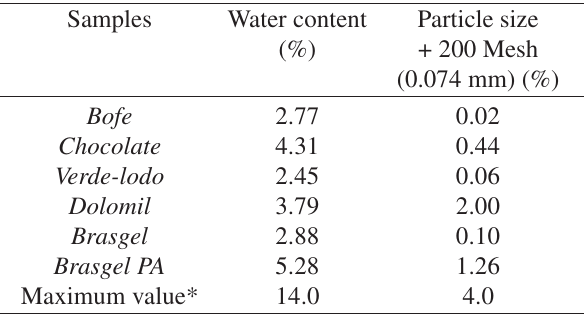
Table 1. Water content and particle size for the natural and indus- trialized bentonites.